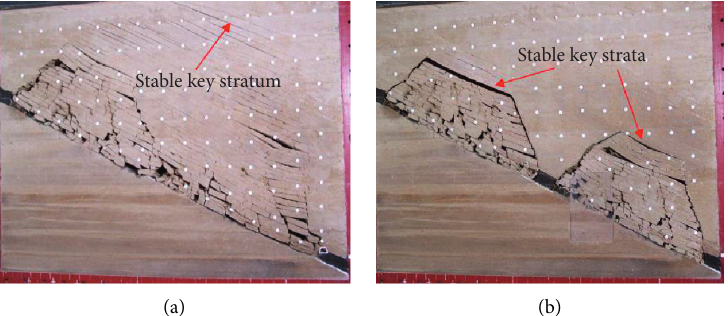
Figure 13: Stable strata development for the two methods: (a) SLL; (b)